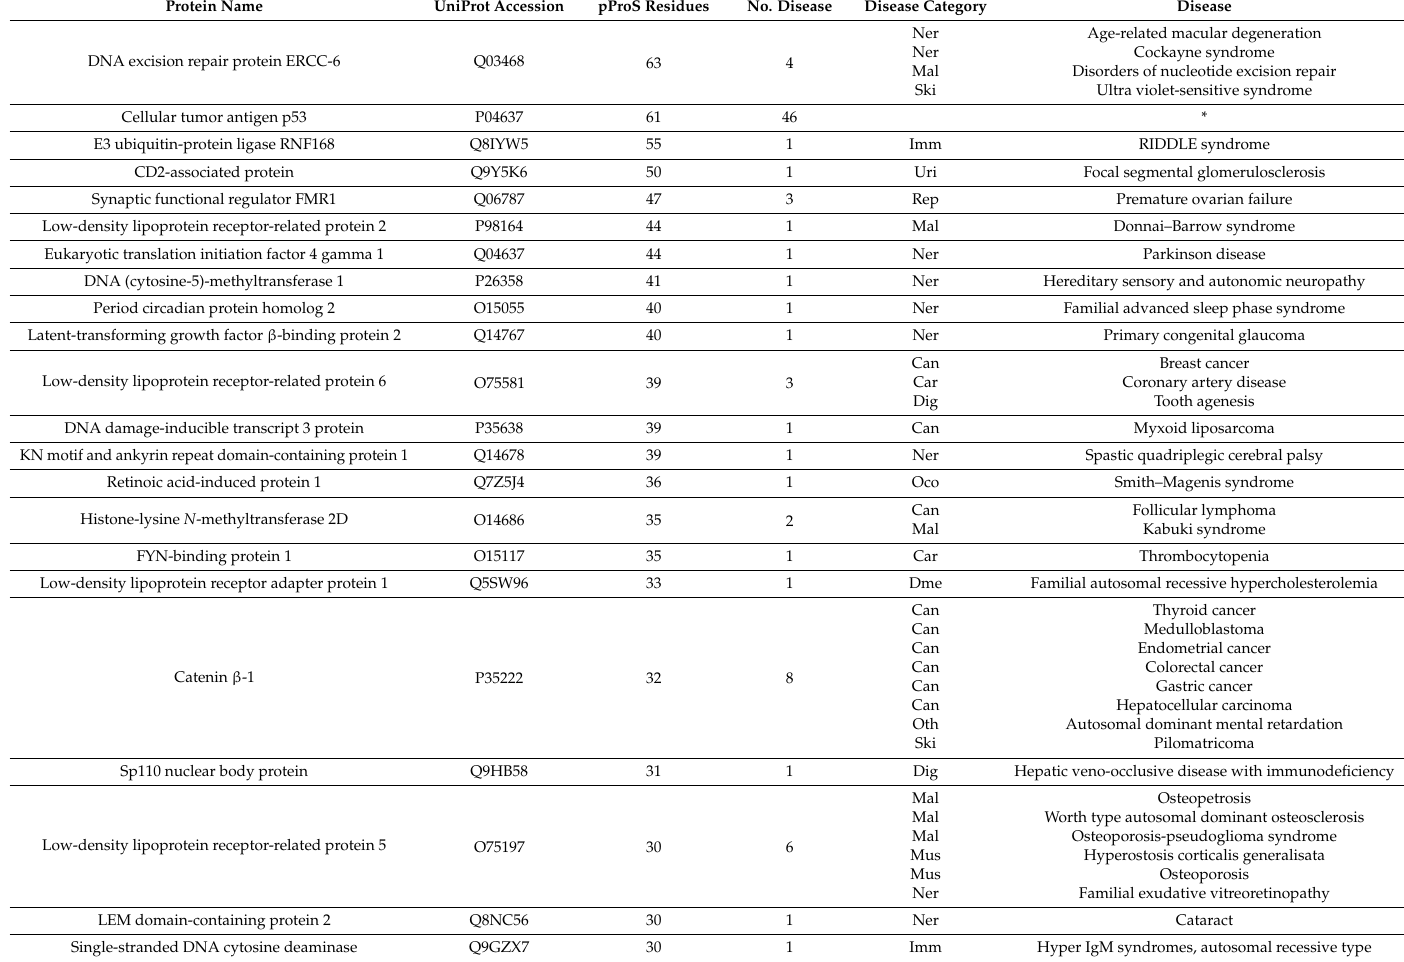
Table 3. The list of the proteins with long